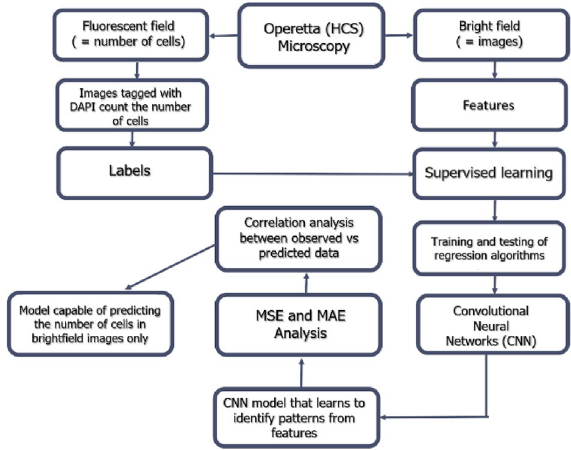
Figure 1. Data processing